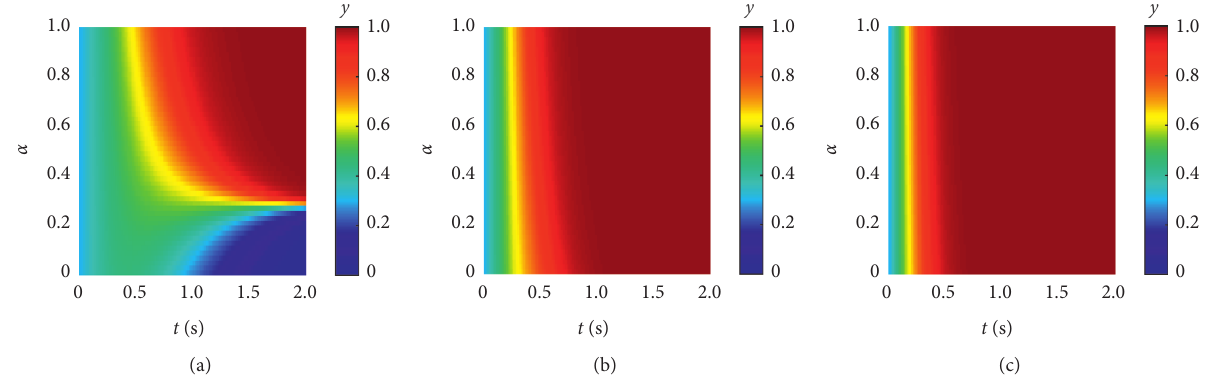
Figure 7: Evolutionary convergence of the proportion of giving way strategy under different penetration rates of the connected autonomous � 1; (b) M � 5; (c) M � 9. bus. (a) M NG NG NG